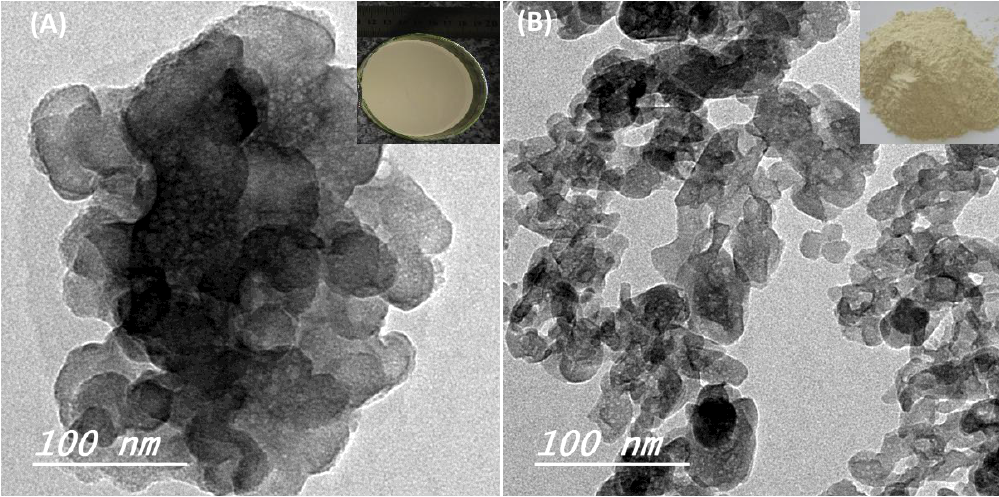
Figure 3. TEM morphology of non-sintered (dried) ( A ) and sintered (heat treated at 650 °C) bone mineral powders ( B ). Inset 2D images show the greenish-beige color of the apatite powders obtained by the biosynthesis method.